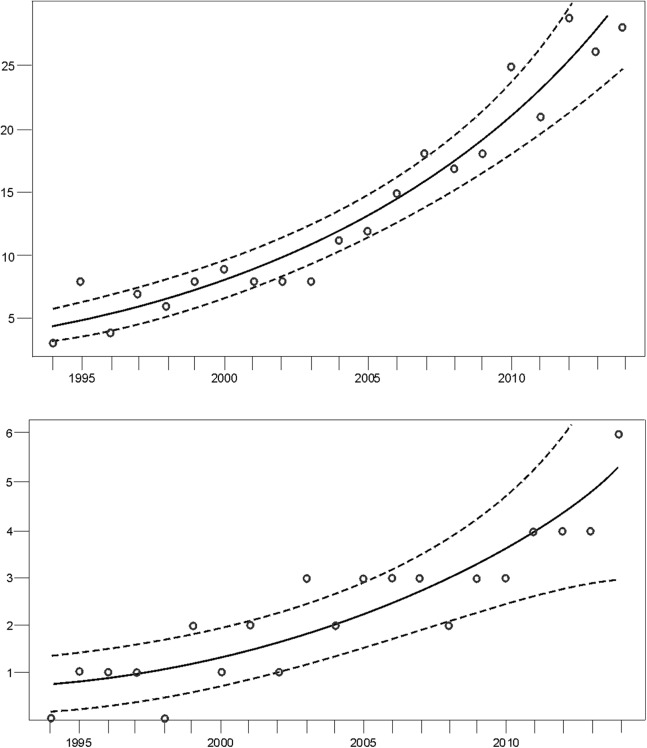
Trend of the number of females with COY (dots) fitted by Poisson regression (lines) from 1994–2014.Data for the (A) western and the (B) eastern subpopulations of brown bears in the Cantabrian Mountains. The 95% confidence limits are indicated with dashed lines.